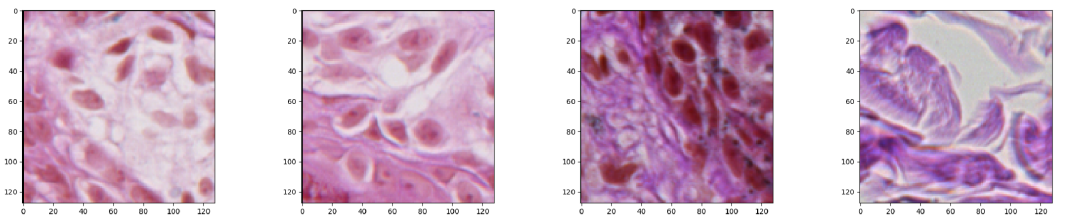
128 pixels each (windows of such size typically ×